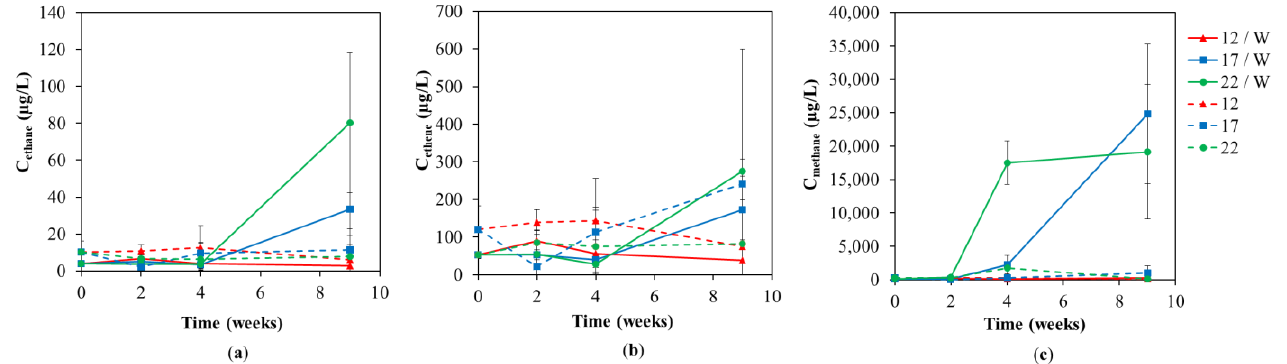
Figure 3. Individual concentrations of dechlorinated products ( a ) ethane ( b ) ethene and ( c ) methane in groundwater at different lab test temperatures of 12 °C, 17 °C, and 22 °C during the lab-scale test with and without whey addition.